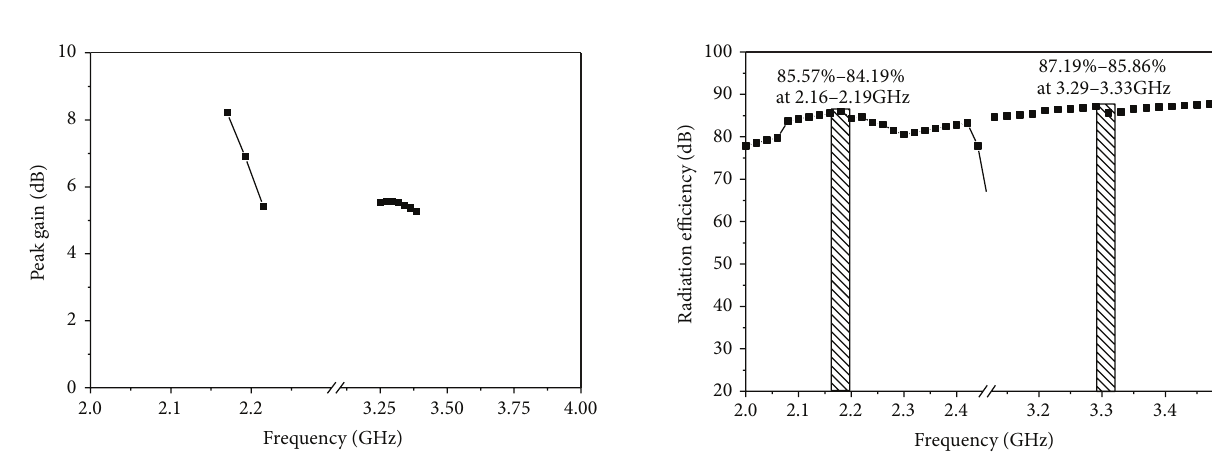
Figure 13: Measured gain versus frequency. Figure 14: Radiation efficiency of the proposed